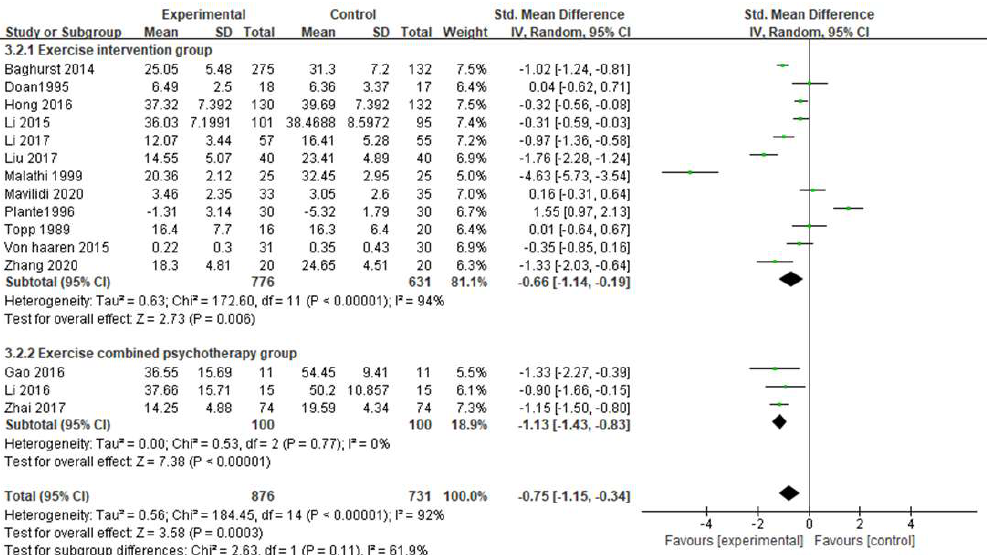
Figure 7. Subgroup analysis of intervention method [17–20,22–32].